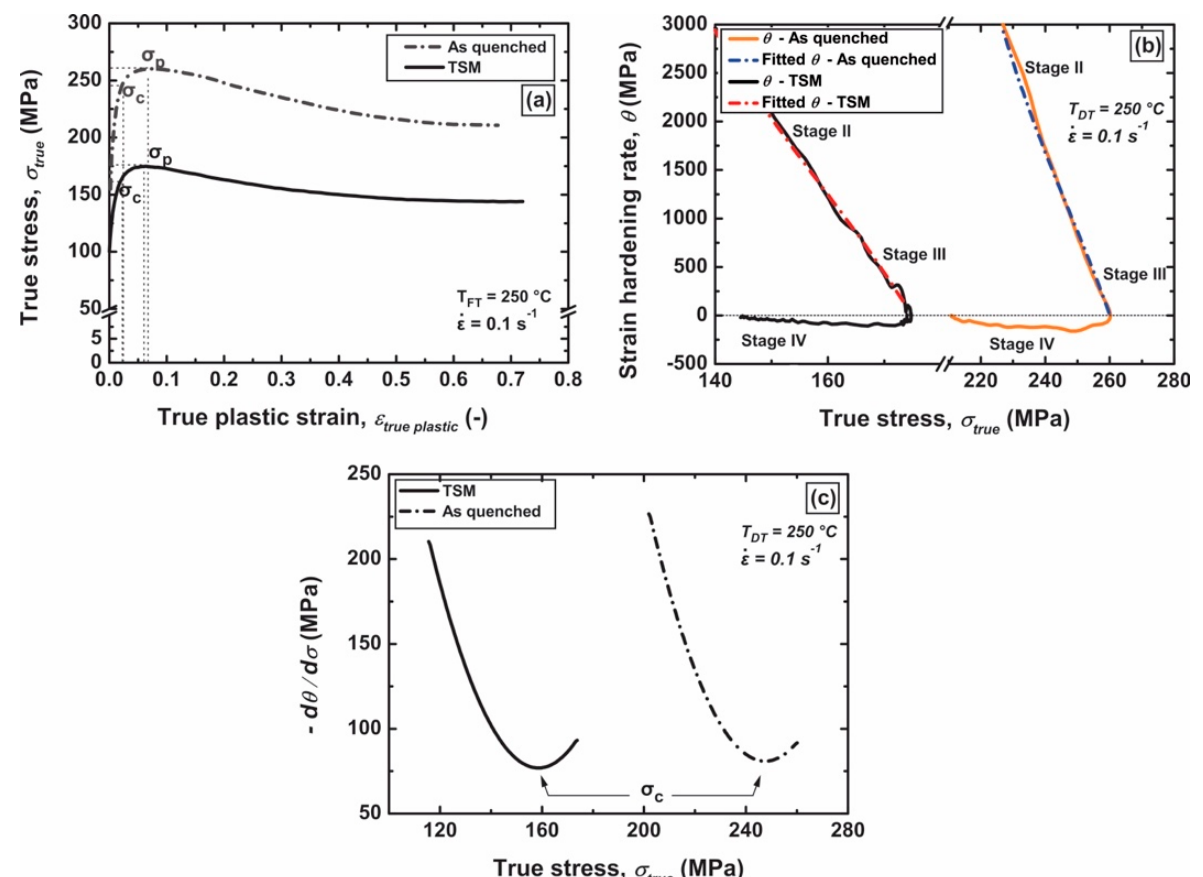
Figure 5. ( a ) Selected hot deformation behavior of the as ‐ quenched and TSM microstructures at de ‐ formation temperature of 𝑇 (cid:3005)(cid:3021) (cid:3404) 250 °C and strain rate of . ε = 0.1 s − 1 to determine the critical stress. ( b ) Measured experimental and fitted strain-hardening rate θ and ( c ) derivation of the θ − σ true plot with respect to true stress σ true , to represent the critical stress σ c at the minimum of d θ / d σ true .